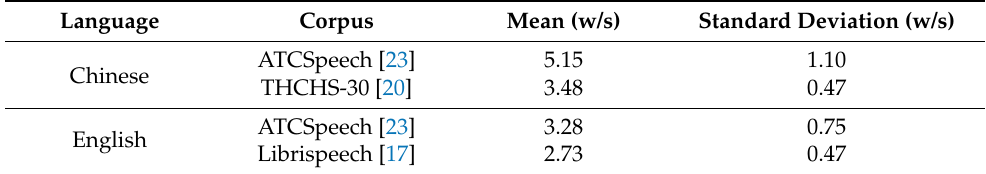
Table 2. The comparison of the speech rate for different speech corpus